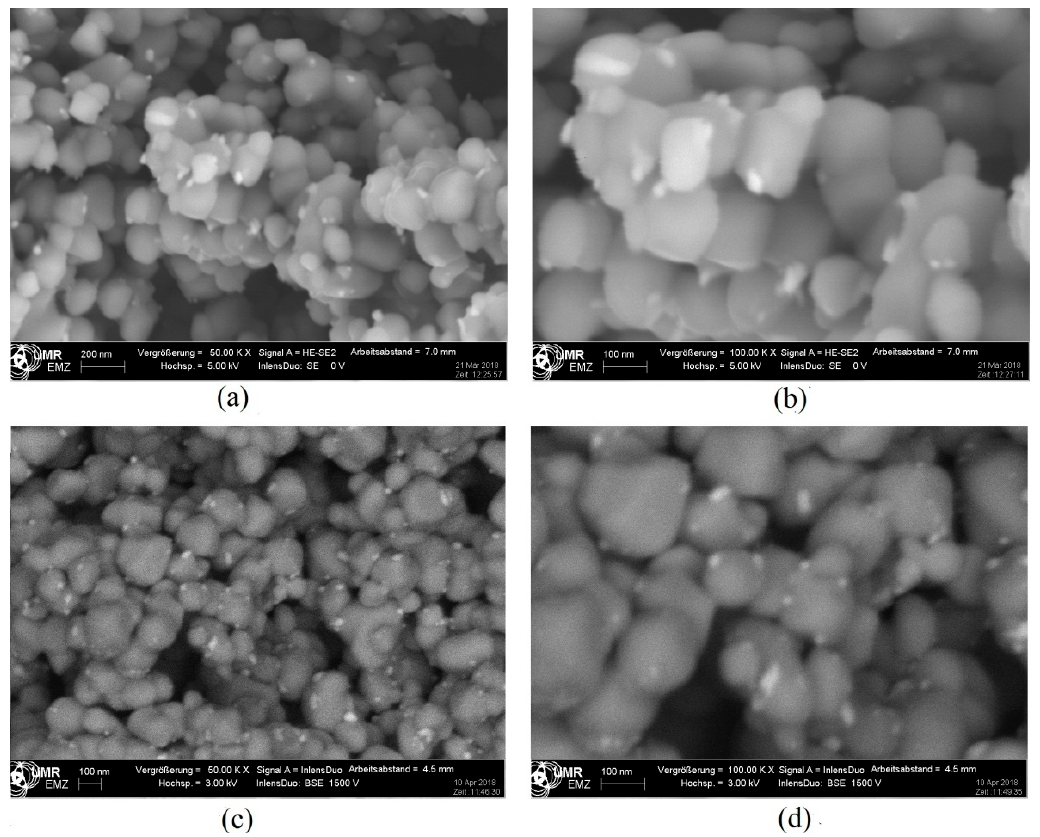
Figure 5. SEM images of Ag/TiO 2 4% in ( a ) 50,000 and ( b ) 100,000 magnifications (backscaterred electron (BSE) detector used for images ( c ) and ( d